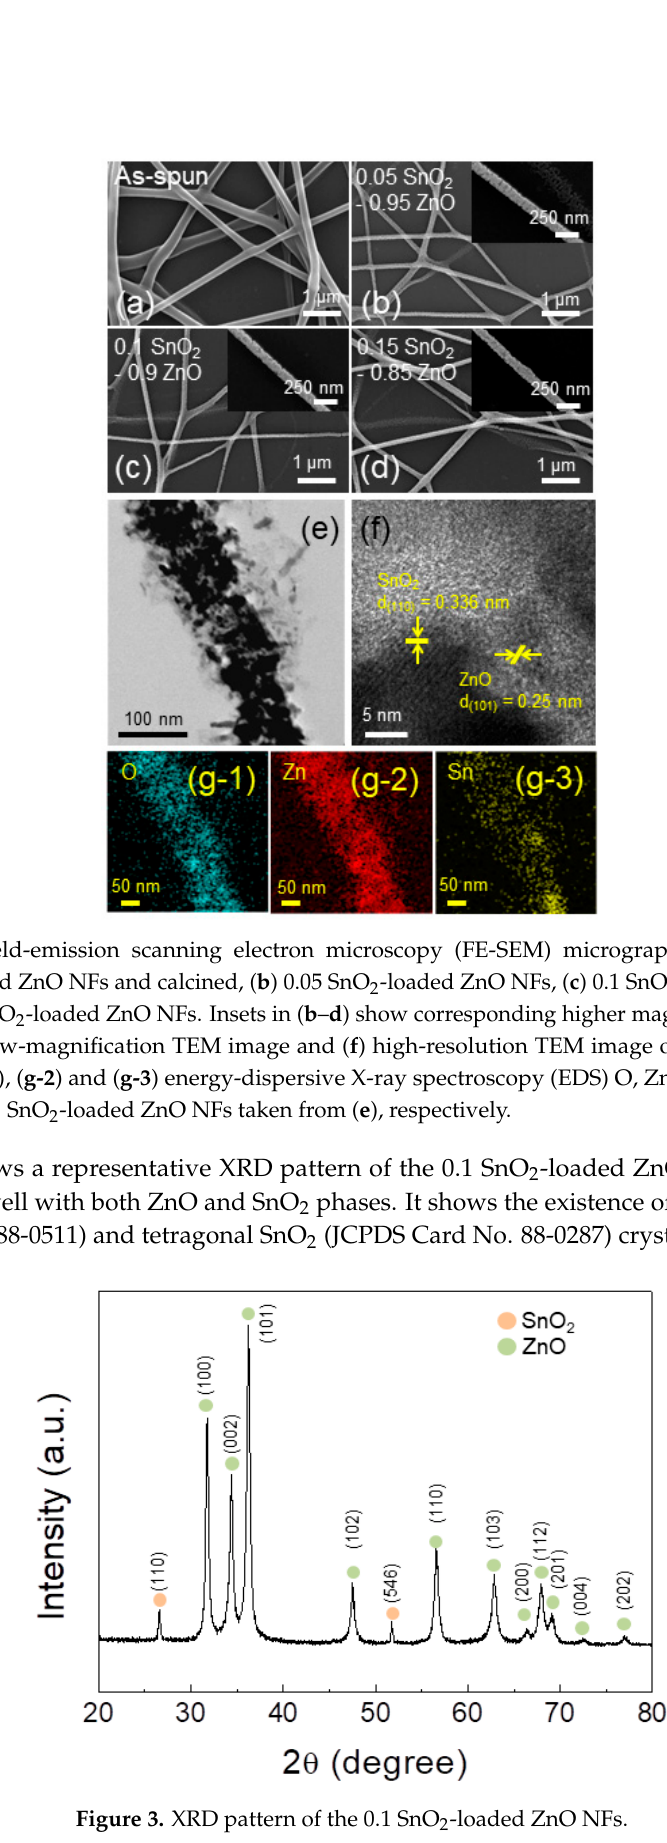
Figure 3. XRD pattern of the 0.1 SnO 2 ‐ loaded ZnO NFs.